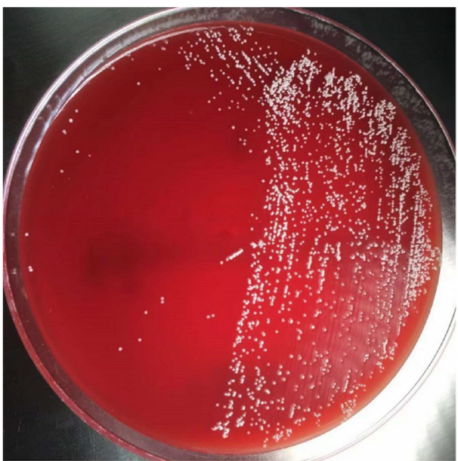
Figure 3. Bacterial colonies on rabbit blood agar after incubation at 37 ◦ C for 5 days.